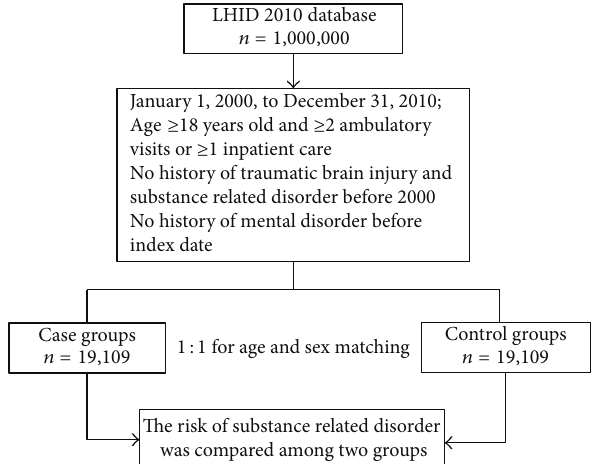
Figure 1: Flow diagram summarizing the process of enrollment. LHID: Longitudinal Health Insurance